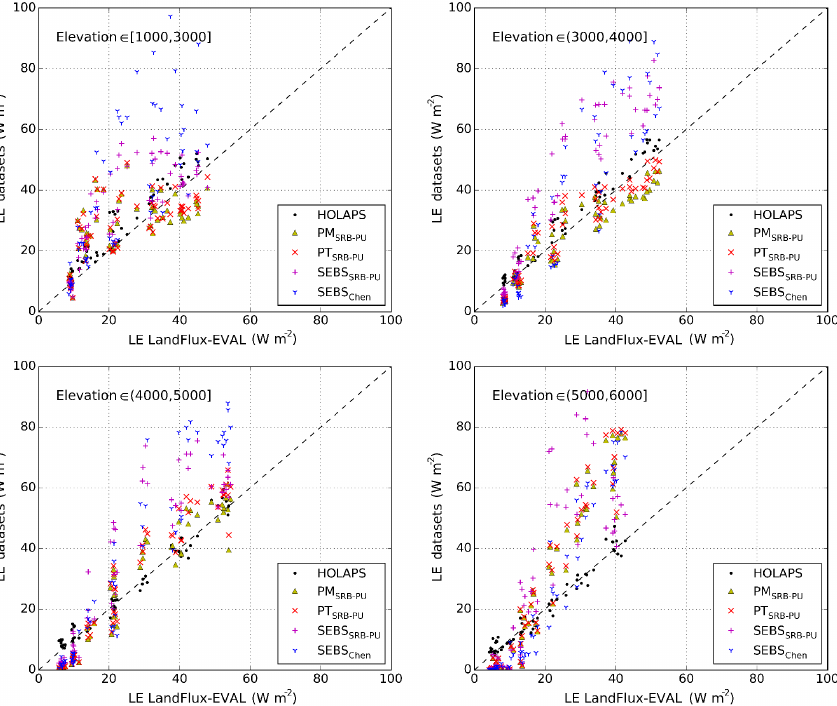
Figure 12. The monthly mean scatter plots of LE between the LandFlux-EVAL benchmark product and other products over different elevation